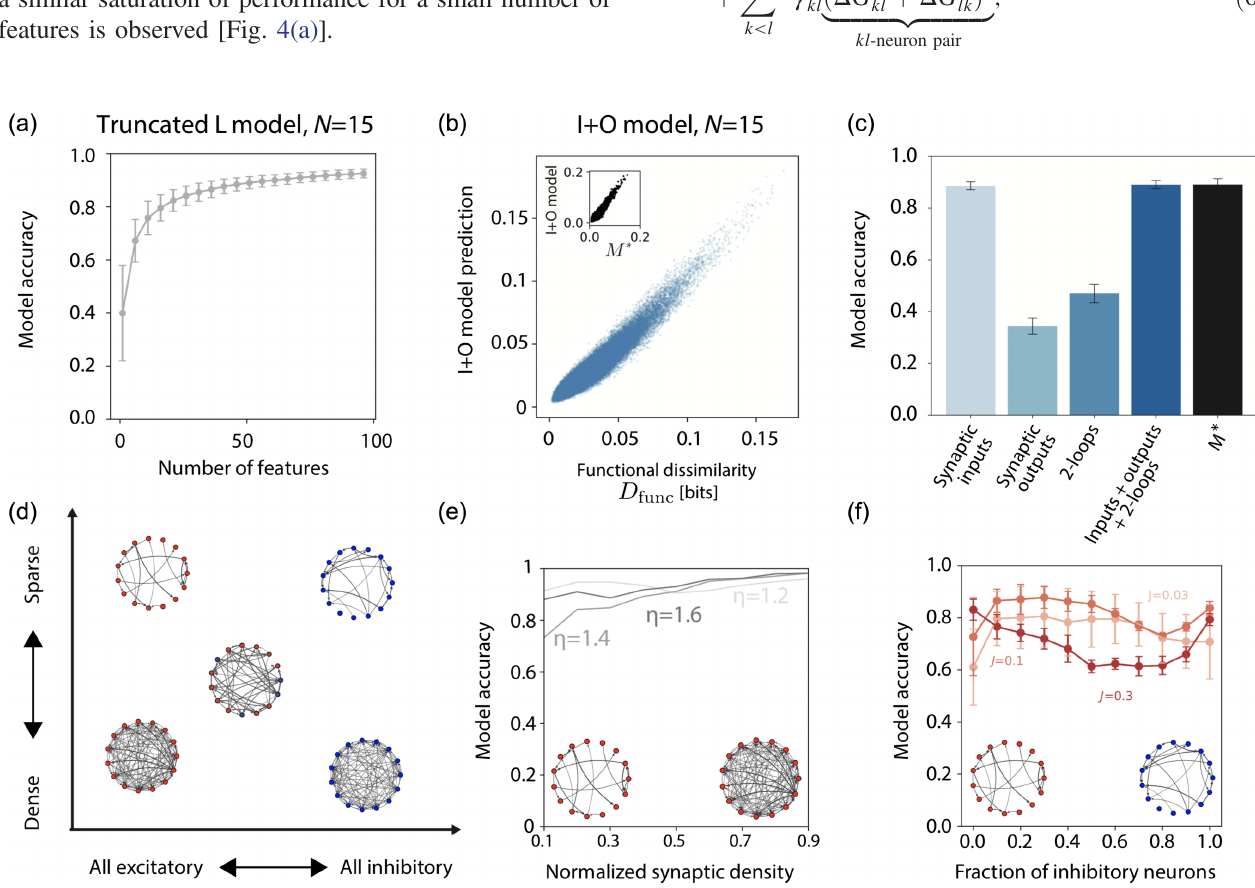
FIG. 4. High performance of the models of the functional similarity of networks, based on our learned architectural features, across different structural parameters. (a) Accuracy of the model when using the first k most important features (largest Euclidean norm), for the ensemble of balanced networks of N ¼ 15 neurons (error bars represent standard deviations over ten different stimuli, spaced between η ¼ 1 . 0 and η ¼ 1 . 8 ). Accuracy is defined as the Pearson correlation between the model ’ s prediction of similarity and D (b) The performance of a model based only on the sum of synaptic inputs to each neuron and the sum of synaptic outputs of each neuron ( I þ O model) predicts the functional similarity of networks of N ¼ 15 neurons as well as the full model using the full matrix M (cid:3) ; the inset shows the high correlation between the M (cid:3) model and the I þ O model (stimulus strength η ¼ 1 . 5 ). (c) Prediction accuracy of models using different subsets of structural features, measured by the mean Pearson correlation coefficient with D the space of network parameters for which we compute the accuracy of the feature-based model. The set of network parameters explored is characterized by the probability of forming a synapse between any two neurons (sparseness) and the ratio between excitation and inhibition in the networks. The drawn networks show examples of networks with the corresponding parameters in different parts of the space. (e) Accuracy of the M (cid:3) model as a function of sparseness of connectivity in the networks, for 3 different stimulus values. (f) Accuracy of the feature-based model that uses the sum of synaptic inputs and sum of synaptic outputs per each neuron ( I þ O ), as a function of the ratio of excitation and inhibition in the network for three different values of J , the mean strength of excitatory synapses in the ensemble (error bars correspond to standard deviations across